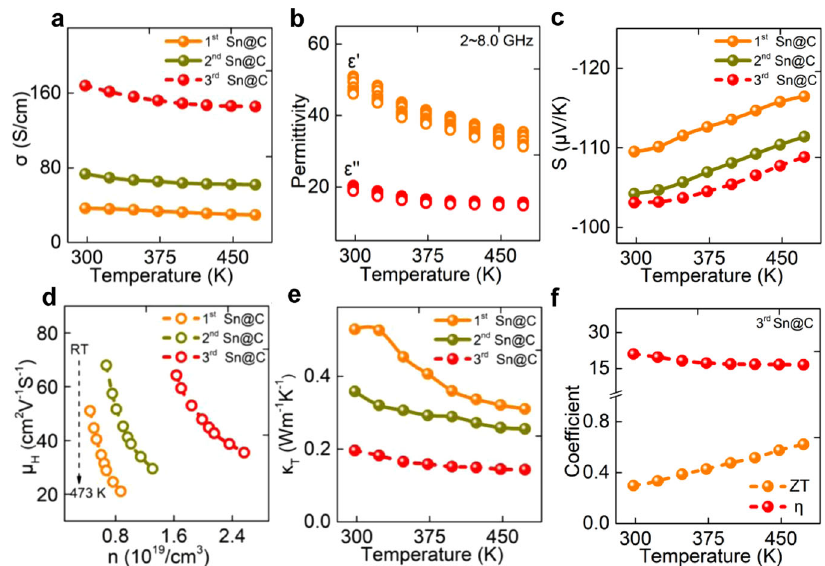
Fig. 3 Analysis of coupled EM wave-to-electricity performance. a In-plane conductivity ( σ ); b the real and the imaginary part of permittivity; c Seebeck coef fi cient; d Hall carrier concentration ( n ) as a function of the mobility ( μ ); e total thermal conductivity ( κ T ); f coupled EM wave-thermal-electricity performance from 298~473 K (applied frequency region: